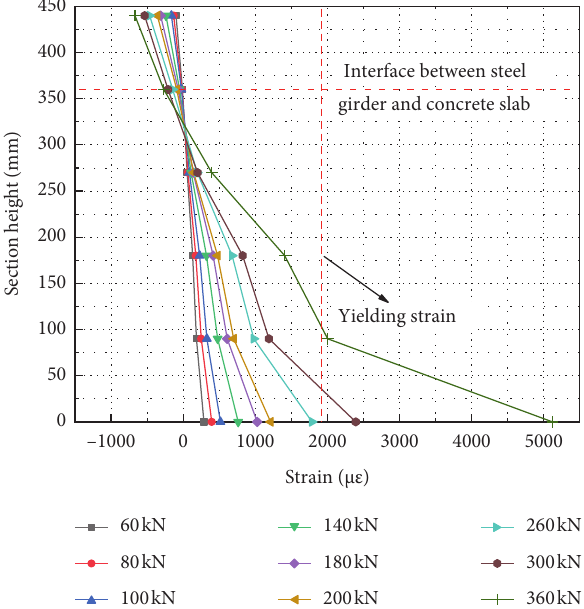
Figure 13: Strain distribution along the height of the section at the loading section (section B